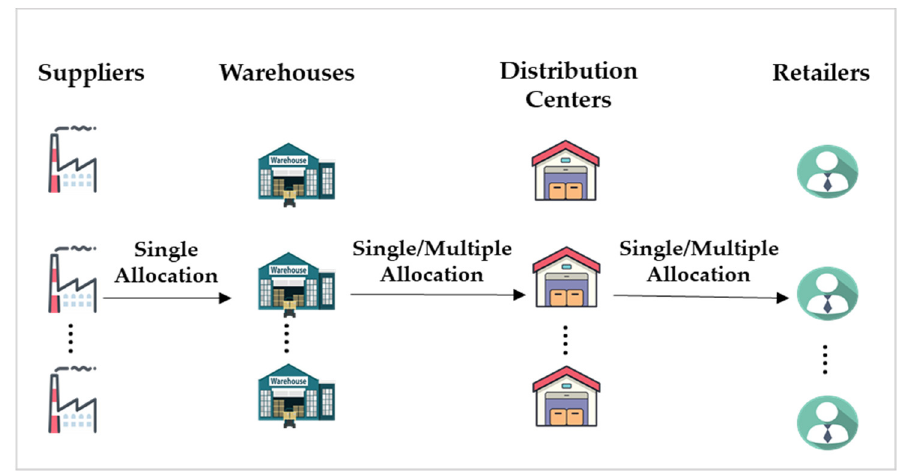
Figure 1. Example of addressed distribution network.